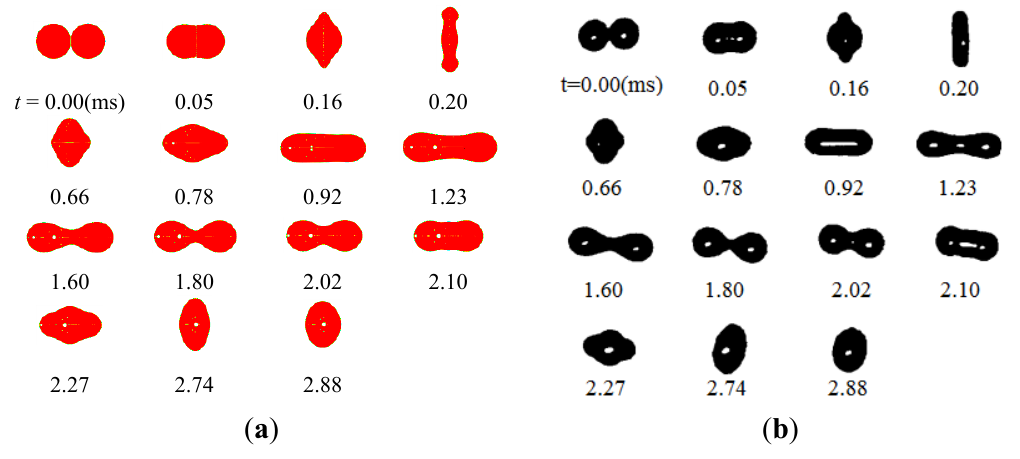
Figure 4. Sequence of coalescence collision: ( a ) Present numerical simulation; ( b ) Obtained by experiment in